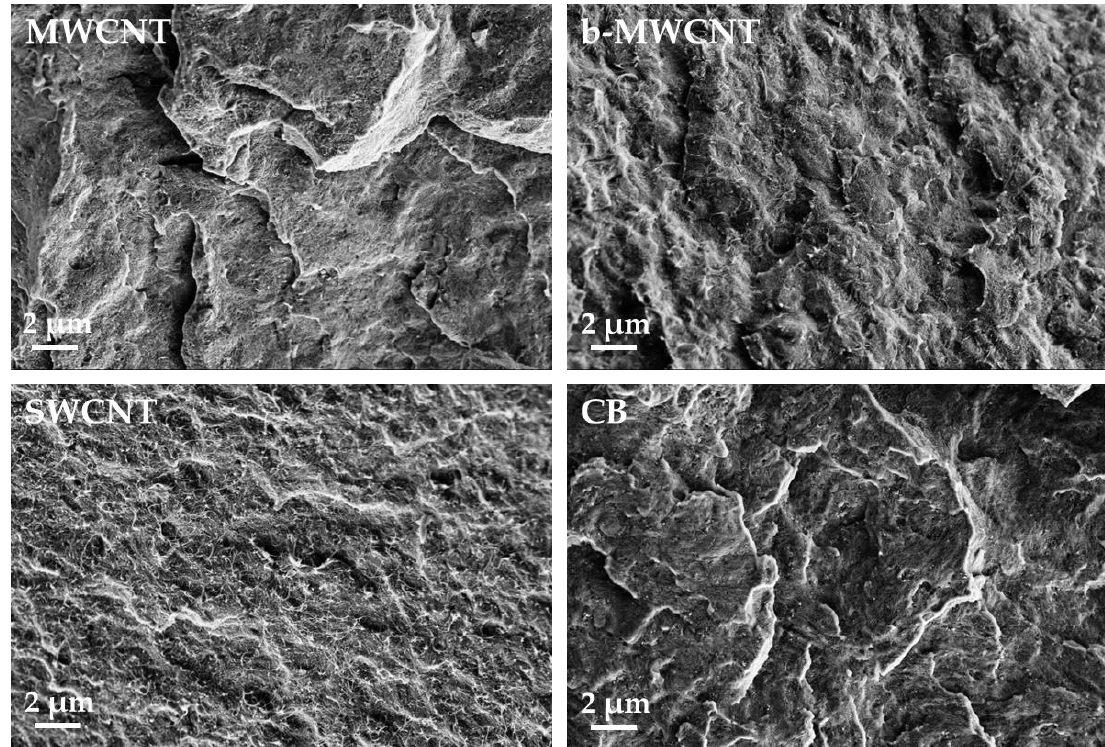
Figure 4. SEM micrographs of poly (vinylidene fluoride) (PVDF) filled with 1.0 wt% of different kind of fillers.